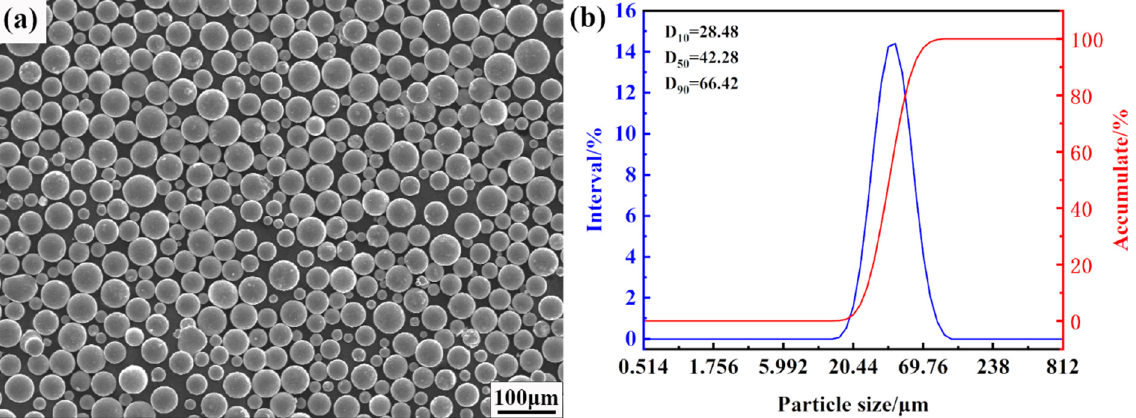
Figure 1. ( a ) Secondary electron micromorphology of 316L metal powder (SEM) and ( b ) particle size distribution of 316L metal powder.